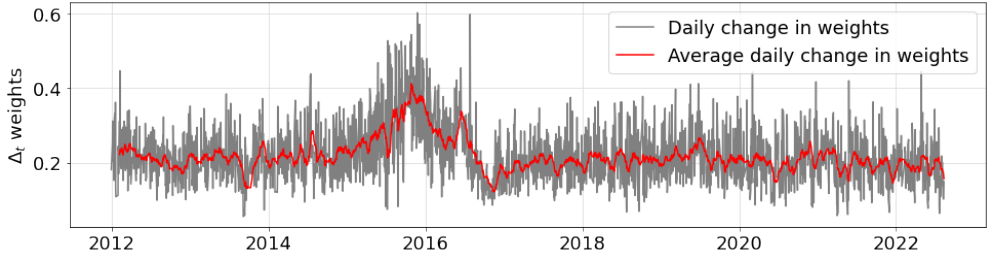
Figure 4. The daily ratio of shared to be re-weighted in the heuristic reward-risk 100 portfolio, taking into consideration both buy and sell orders. The average daily change in weight denoted with the red line is calculated as a rolling window average of the past 20 days’ changes in weight.